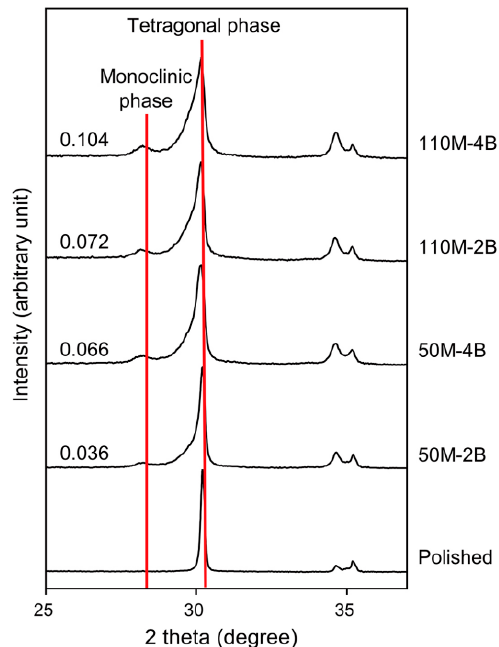
Figure 3. X-ray diffraction patterns for the polished and sandblasted zirconia surfaces, showing the increased monoclinic phase after sandblasting. The values on the left side of the graphs indicate the m-phase/(t-phase + m-phase) ratios. Monoclinic phase was not detected for the polished group.